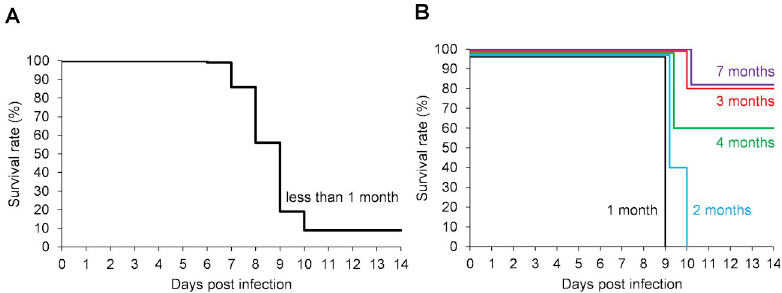
Fig 1. Survival (Kaplan-Meier curve) in the acute phase of hamsters subcutaneously infected with L . interrogans . Groups of four- to six-week-old male Golden Syrian hamsters were subcutaneously infected with 1 × 10 4 cells of L . interrogans serovar Manilae strain UP-MMC-SM. The leptospires used for injection were cultured for (A) less than 1 month and (B) 1 (black), 2 (blue), 3 (red), 4 (green), and 7 (purple) months in Korthof’s medium after in vivo passage. A, n = 43 hamsters; B, n = 5 hamsters per